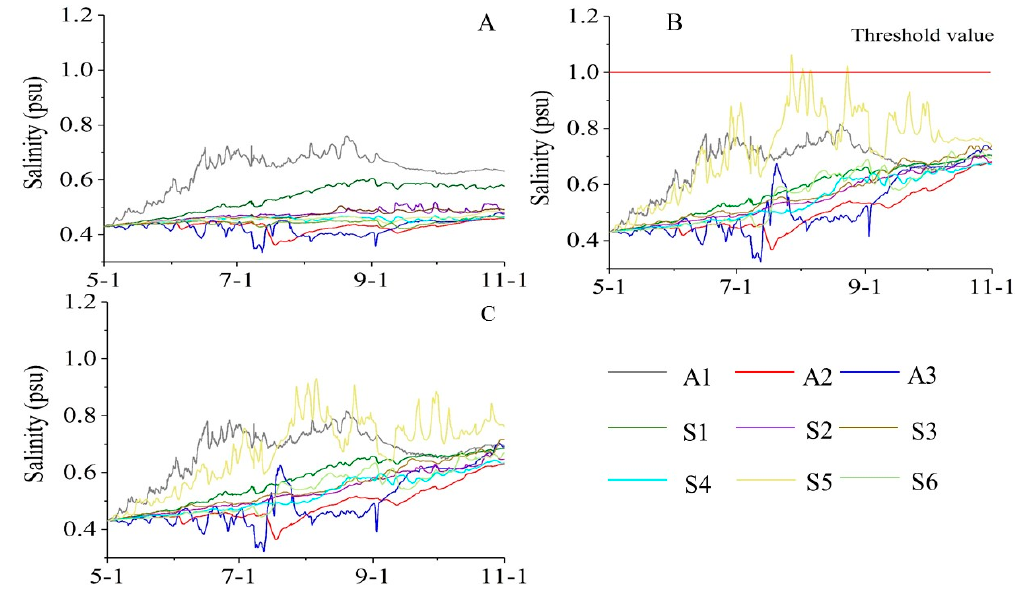
Figure 9. Salinity variation under nine stations of irrigation districts. ( A )indicates existing irrigation districts; ( B ) indicates 100% area of Qian’an irrigation discharge; ( C )indicates 75% area of Qian’an irrigation discharge.